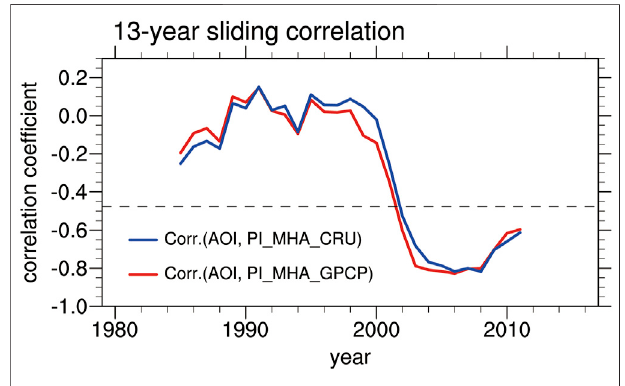
FIGURE 1 | 13-years sliding correlation coef fi cients between winter Arctic Oscillation index (AOI) and simultaneous precipitation index over the MHA (PI_MHA) derived from CRU (PI_MHA_CRU; blue curve) and GPCP (PI_MHA_GPCP; red curve) data. Both indices are detrended and normalized. The horizontal dashed lines denote the 90% con fi dence level based on the Student ’ s t -test.